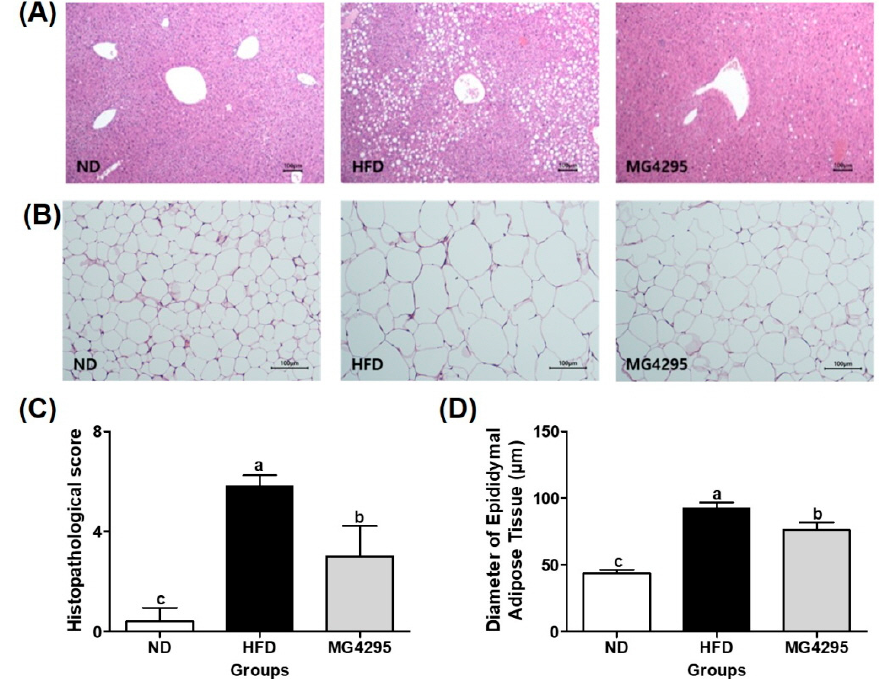
Figure 4. Histopathological alterations in the liver and epididymal adipose tissues. Representative photographs of H&E-stained liver tissues ( A ) and epididymal adipose tissues ( B ), histopathological scores of liver tissues ( C ), and diameters of epididymal adipose tissues ( D ) in HFD-induced mice. Scale bars = 100 µ m. The results are presented as mean ± SD ( n = 8). Different letters indicate a significant difference at p < 0.05.